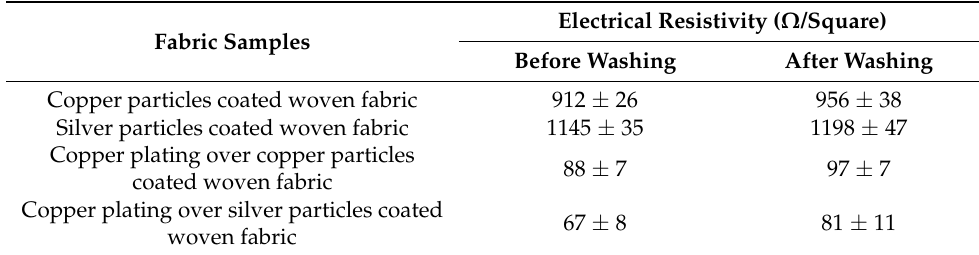
Table 3. Electrical resistivities of conductive fabrics before and after washing.